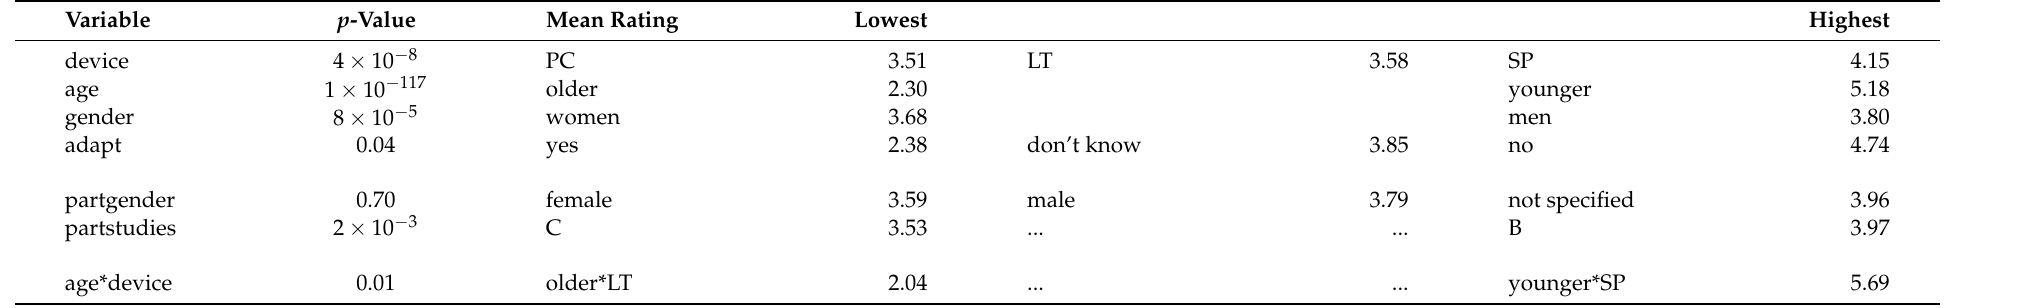
Table A2. Expertise, p -value from ANOVA with associated mean ratings.